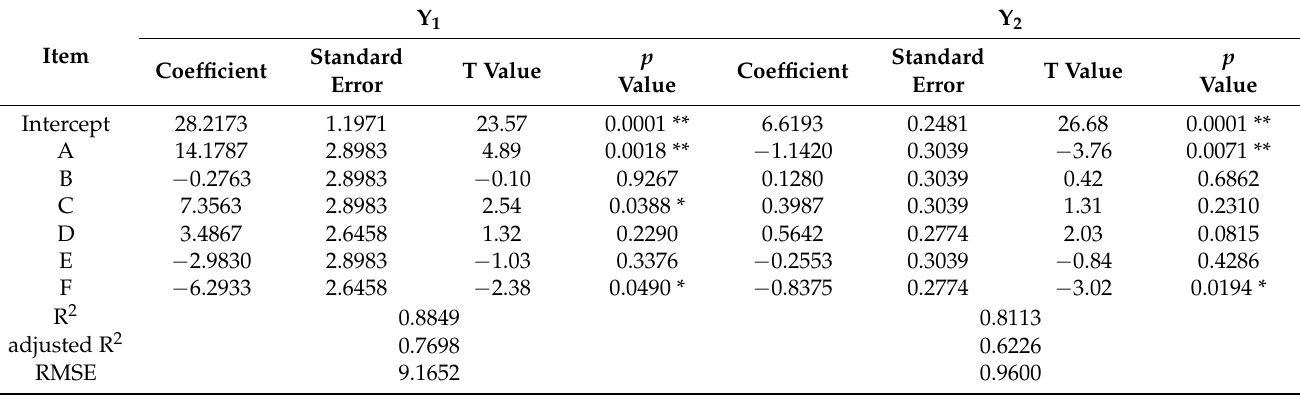
Table 1. Analysis of the significant parameters in the PBD